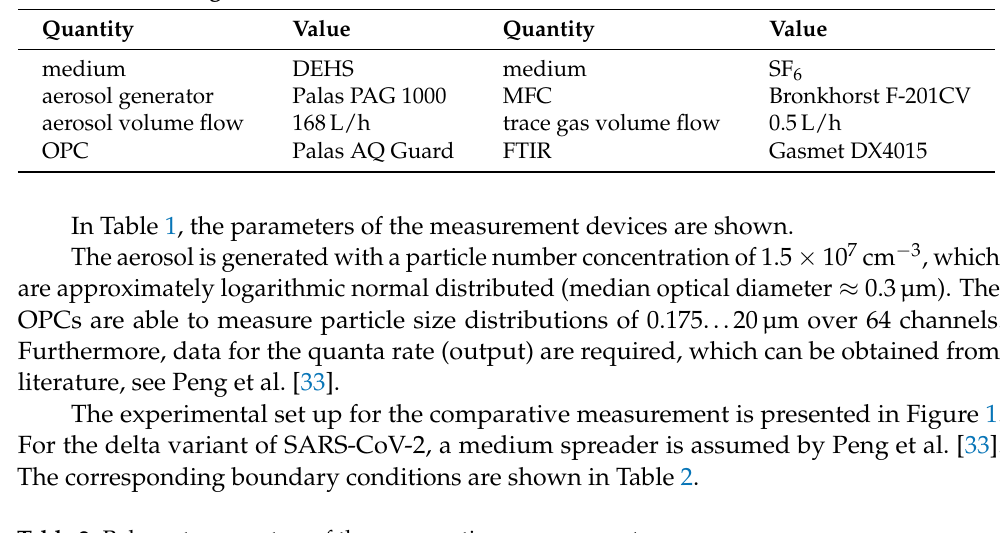
Table 2. Relevant parameters of the comparative measurement. Quantity